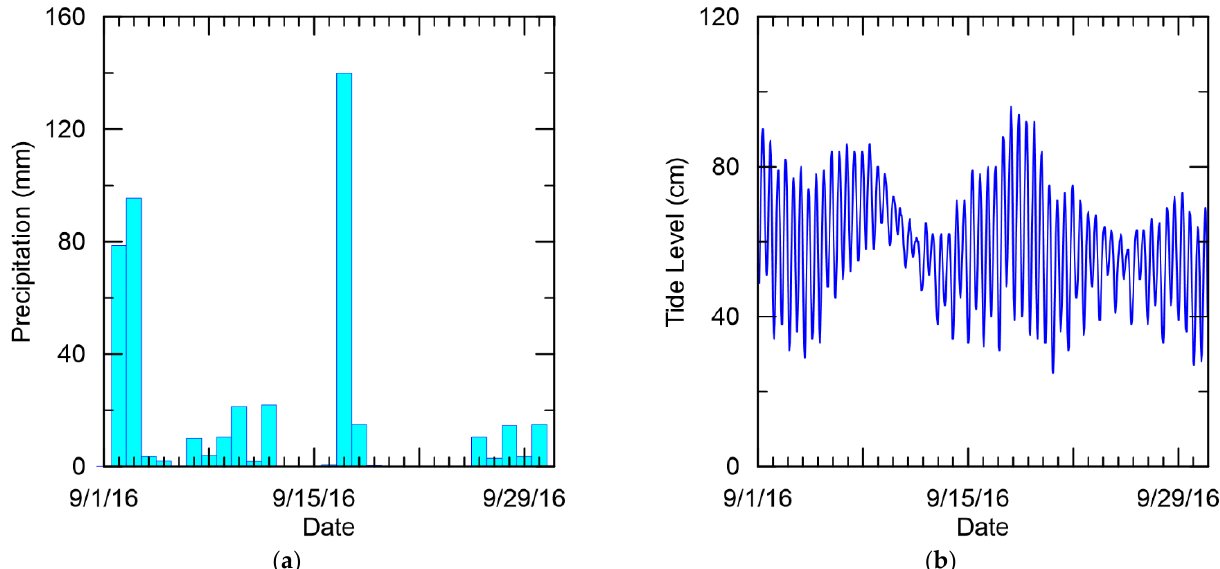
Figure 4. ( a ) Precipitation in Gyeongju and ( b ) tide levels in nearby Ulsan for the month of September 2016.